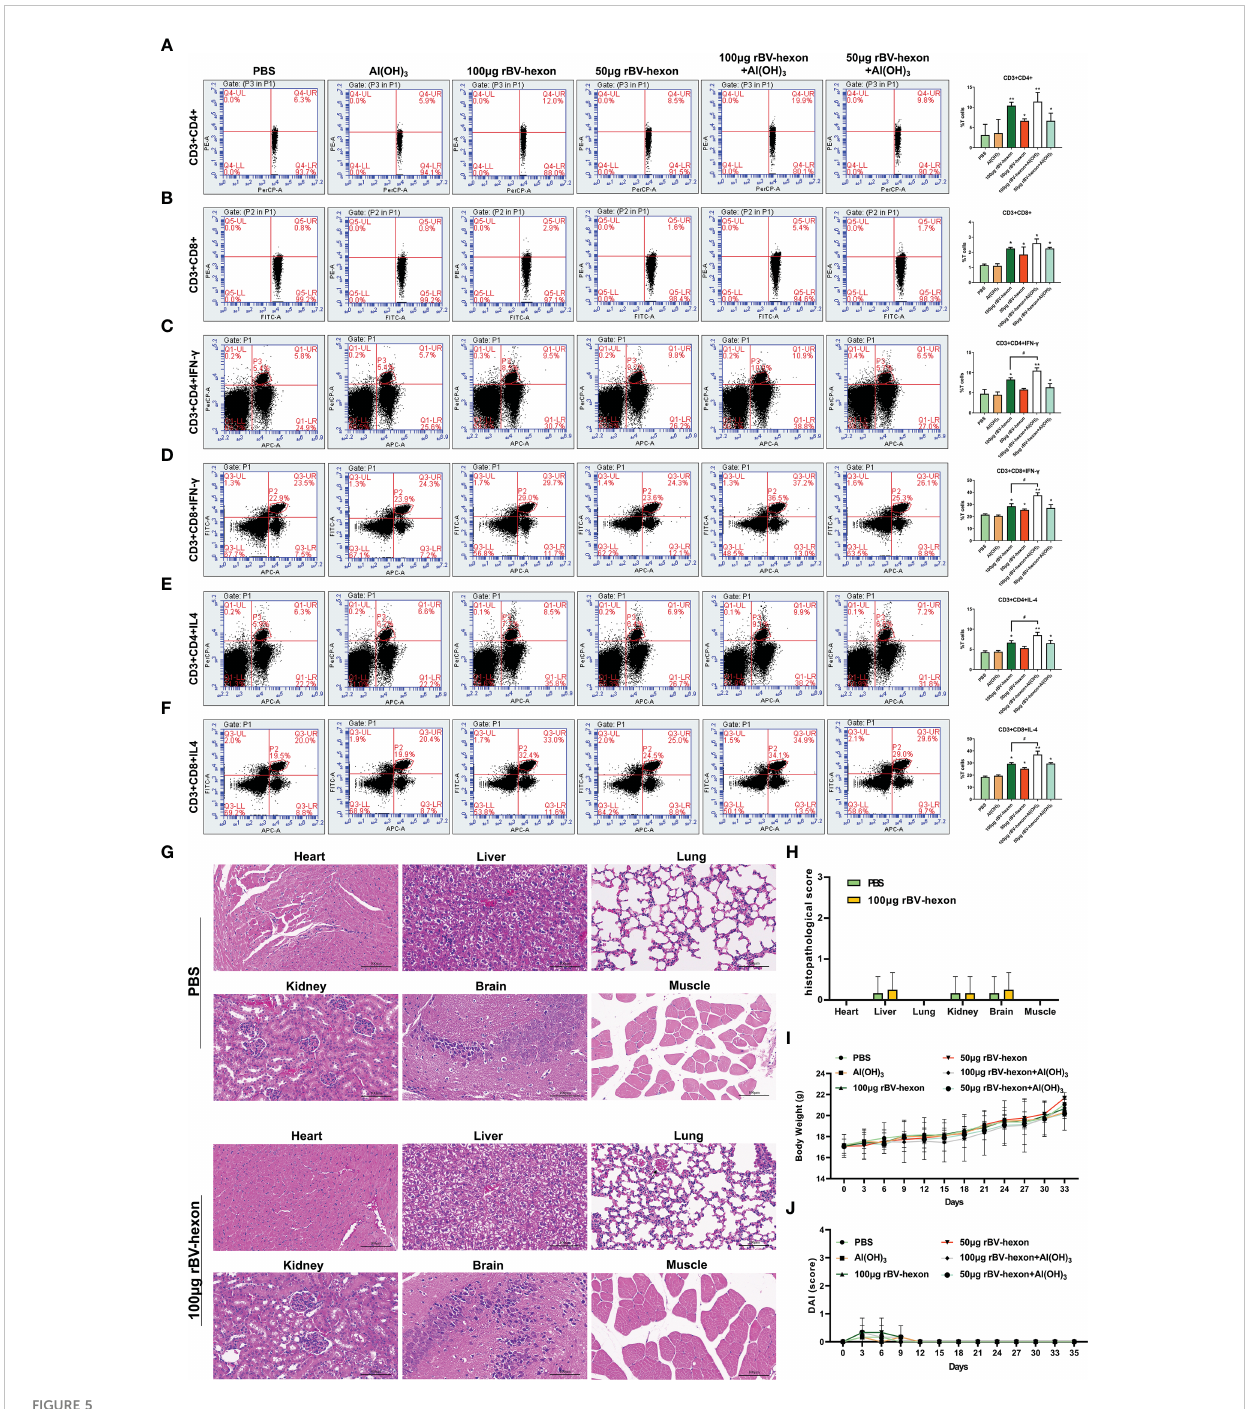
FIGURE 5 T-cell response induced by rBV-hexon inoculation. (A, B) Percentage of CD3 + CD4 + and CD3 + CD8 + cells in spleen lymphocytes detected by fl ow cytometry. (C – F) CD4 + and CD8 + T-cell activation was evaluated by detecting secretion of IFN- g and IL-4. (G) HE staining was used to analyze the pathological changes of various organs and tissues. (H) Histopathological scores of mice. (I) Weight change of mice. (J) DAI score of mice. The experiments were repeated over three independent experiments. Error bars represent standard deviation (SD). * P < 0.05; ** P < 0.01; #P <